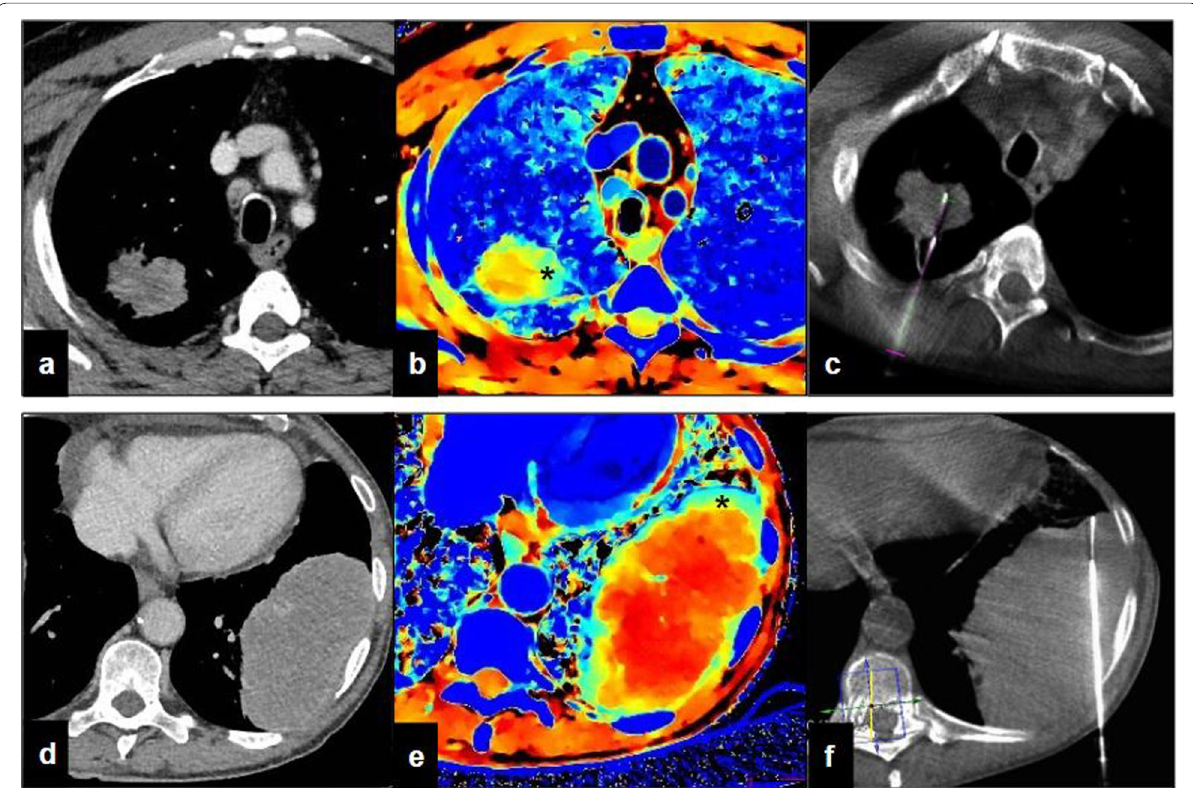
Fig. 1 Percutaneous lung biopsy. a Axial routine diagnostic image in a patient with solid lung lesion at the upper right lobe. b Effective atomic number-based reconstruction at the same level: the lesion is characterised by inhomogeneous intralesional atomic number with a central area showing a reduced atomic number (yellow–red) and a medial eccentric area showing a higher atomic number (light blue, asterisk). c Intraprocedural cone beam computed tomography (CBCT) shows that the needle has been located in the area with the highest atomic number. d Axial routine diagnostic image in a patient with solid lung lesion at the lower left lobe. e Effective atomic number-based reconstruction at the same level: the lesion is characterised by inhomogeneous intralesional atomic number with a central area showing a reduced atomic number (yellow– red) and an external circular area showing a higher atomic number (light blue, asterisk). f Intraprocedural CBCT shows that the needle has been located in the area with the highest atomic